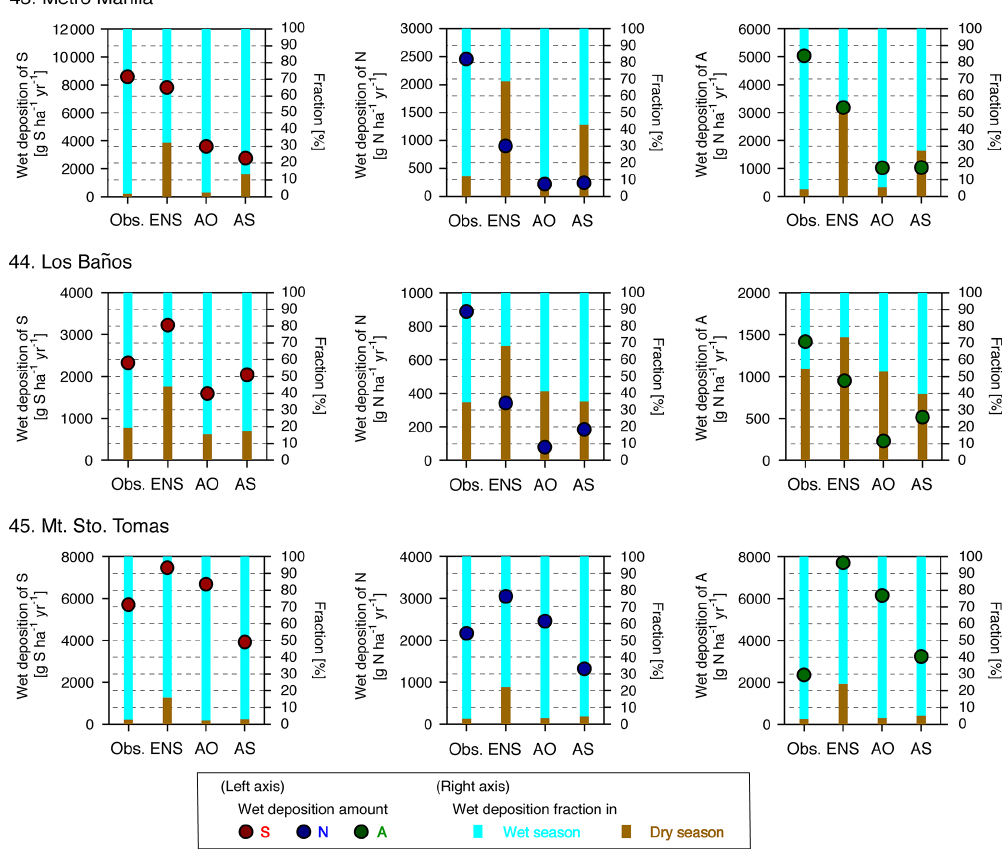
Figure 14. Observed and simulated annual accumulated wet deposition amounts of S, N, and A, and the fraction of wet deposition during the wet and dry seasons at three sites in the Philippines. The annual accumulated wet deposition amount is based on the months for which wet deposition observations were available (see Fig.